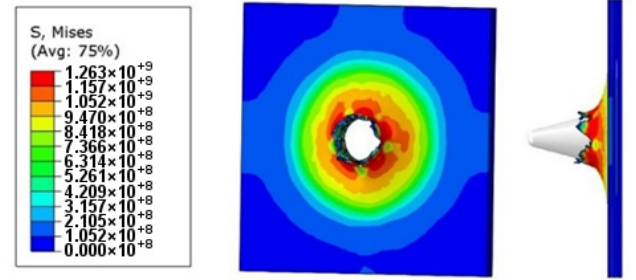
Figure 26. HMH stress visualization for three layers of titanium alloy.